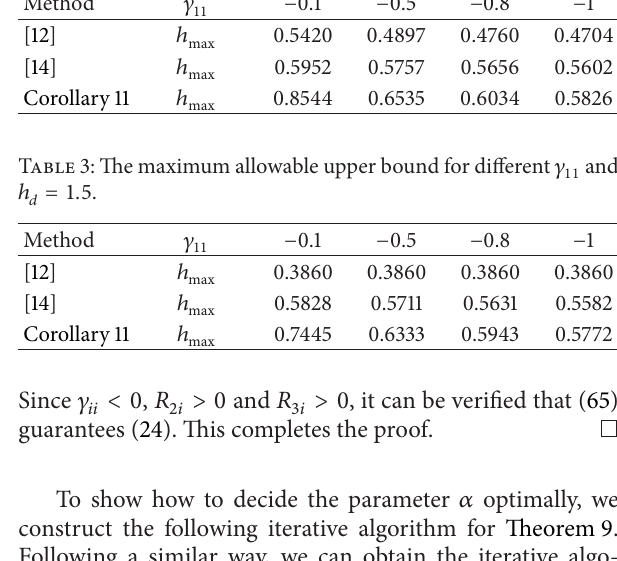
Algorithm 15. Select optimal parameter 𝛼 for maximum delay ℎ